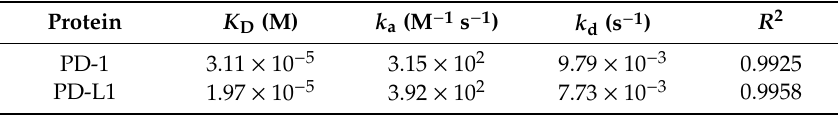
Table 1. The kinetic analysis of KR binding to PD-1 and PD-L1 using BLItz system.